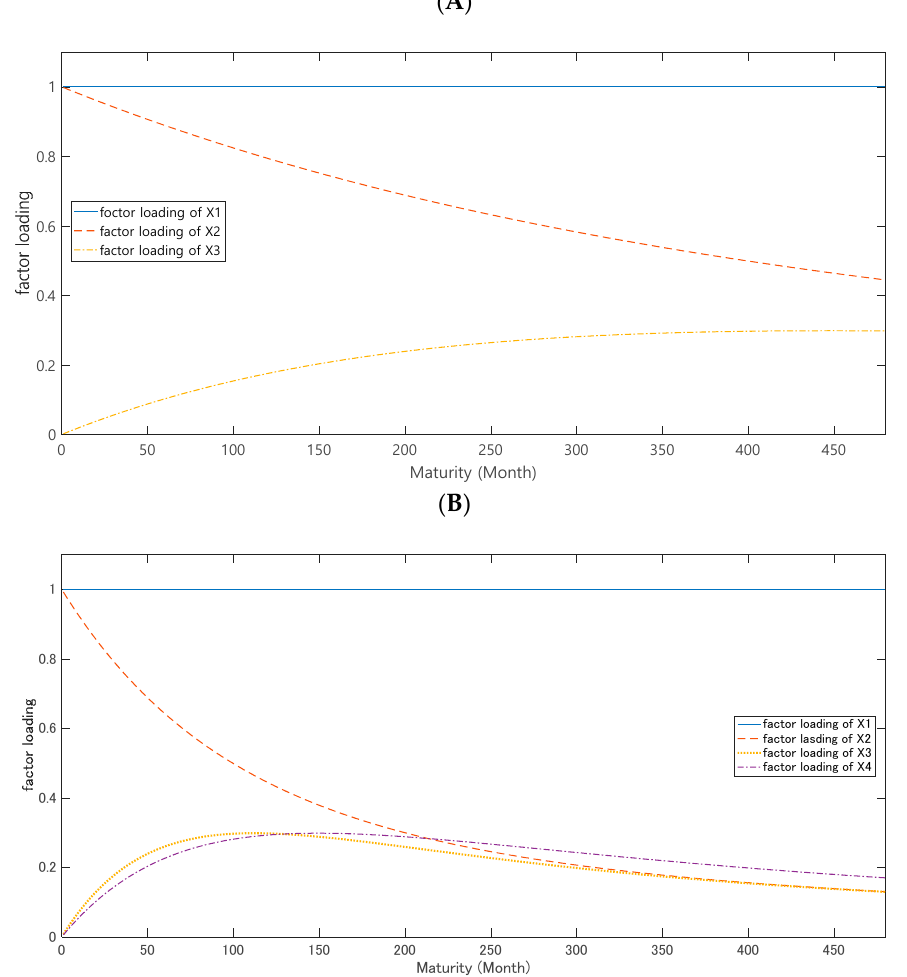
Figure2. FactorloadingsofthedynamicNelson–Siegel(DNS)andthedynamicNelson–Siegel–Svensson (DNSS) models. Note: The first plot represents the factor loadings of the DNS, and the second represents the factor loadings of the DNSS when λ = 0.004, λ 1 = 0.016, and λ 2 = 0.012. A : the dynamics of the factor loadings of the DNS model; B : the dynamics of those of the DNSS model.